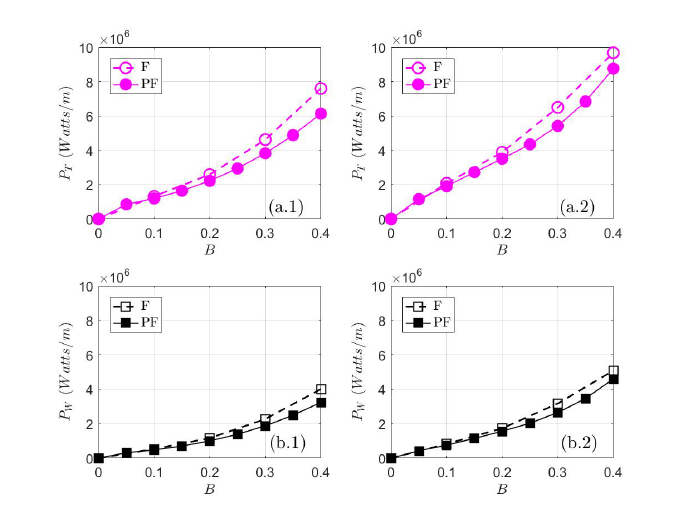
Figure 7. Effect of blockage ratio on P T ( a ) and P W ( b ) for a fence (dash-line) and partial-fence (continuous-line) configuration. Solutions obtained from ADI (*.1) and TVD (*.2).